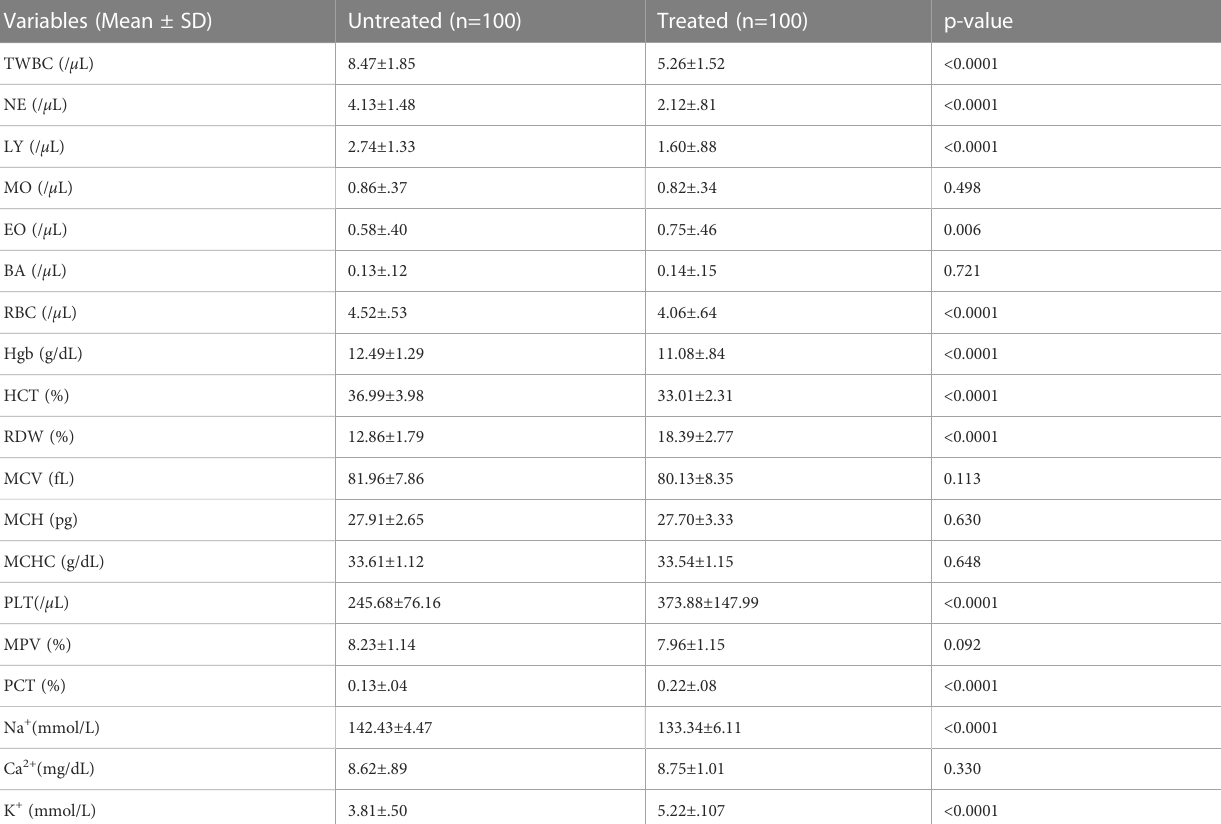
TABLE 3 Comparison of hematological and electrolyte parameters between AC-treated and untreated BC patients. Variables (Mean ±